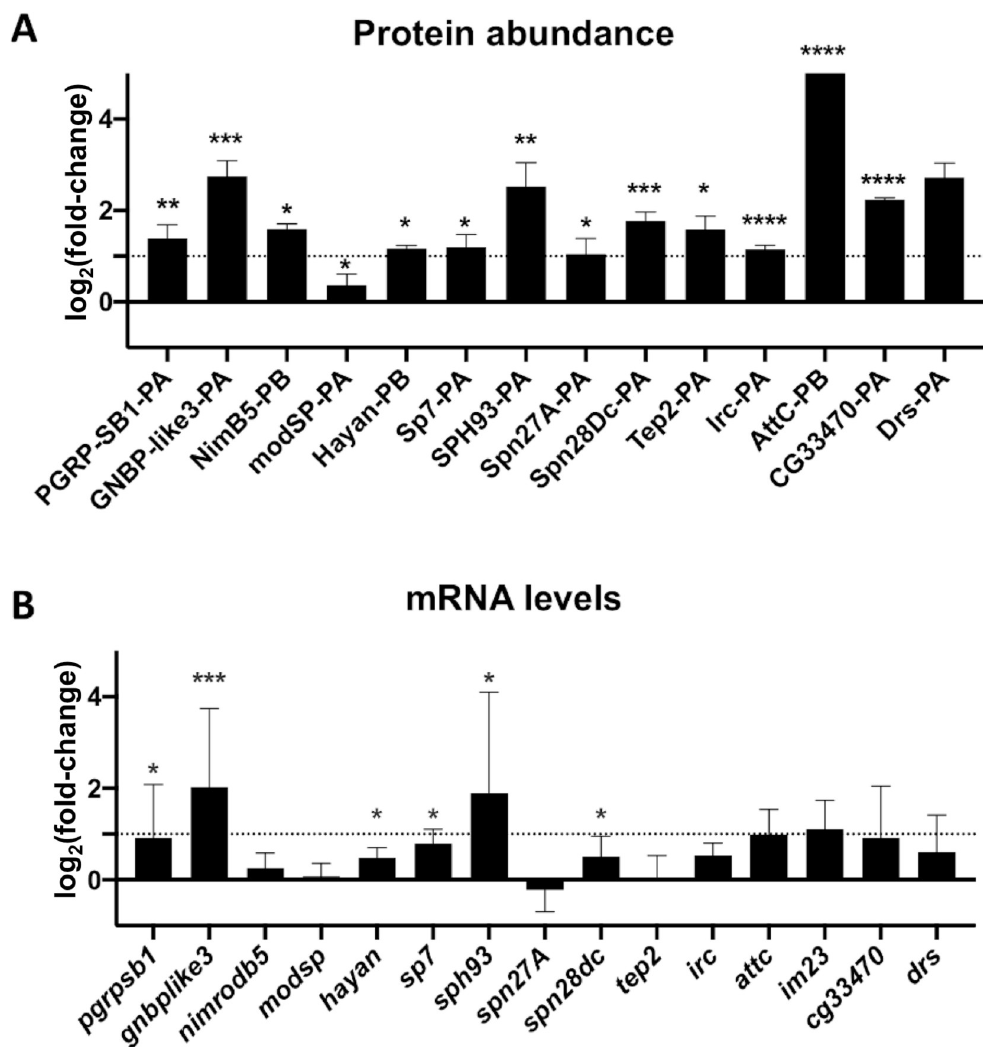
Fig 2. Spiroplasma infection induces a mild transcriptional immune response. (A) Changes in a selection of immune- related protein group abundances quantified by LC-MS/MS. Data are expressed as fold change of the Label-Free Quantification (LFQ) values of Spiroplasma infected hemolymph over the uninfected control (log 2 scale). � , p < 0.05; �� p < 0.005, ��� ; p < 0.005, ���� , p < 0.0005 upon Student t-test. (B) mRNA quantification of a selection of candidate genes in uninfected and Spiroplasma -infected flies. Results are expressed as the fold change of target mRNA normalized by rpL32 mRNA in Spiroplasma -infected flies as compared to uninfected flies (log 2 scale). � , p < 0.05; �� p < 0.005, ��� ; p < 0.0005 upon Mann-Whitney test on Δ Ct values. Each bar represents the mean +/- standard deviation of a pool of at least 2 independent experiments with 3 biological replicates